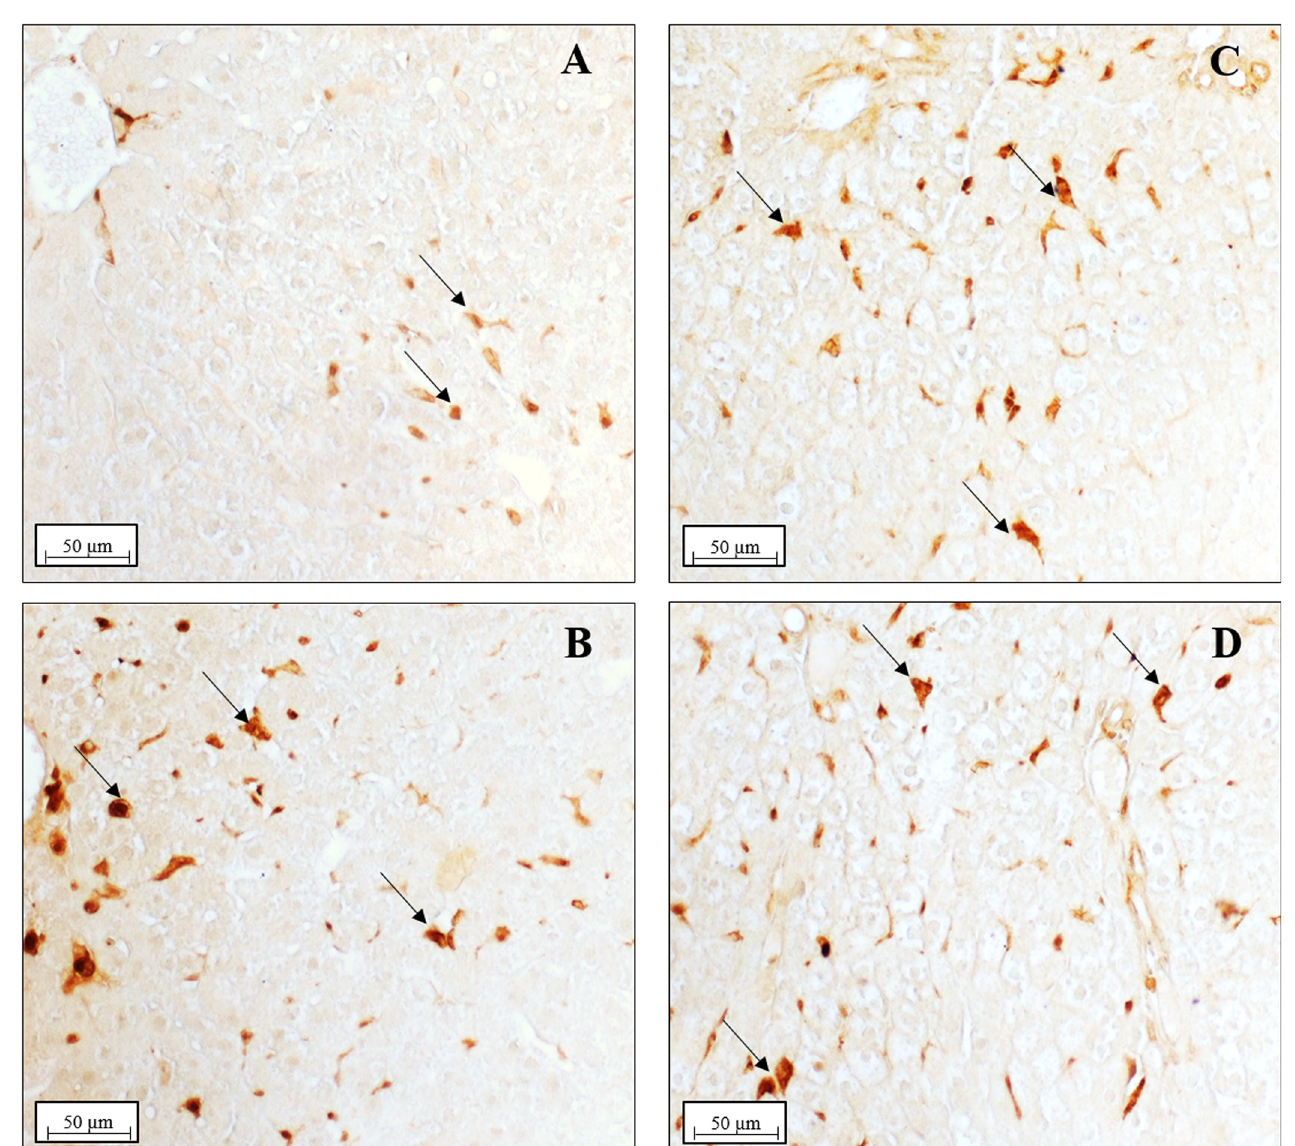
Fig 3. Hepatic Kupffer cells detection. Sections of liver were immunostained with anti-CD68 antibody to detect Kupffer cells in the liver. Panel A, N group; panel B, N+DDE group; panel C, D group; panel D, D+DDE group. Positive cells were evidenced with black arrows. Magnification used: 10X; scale bar applied: 50 μ